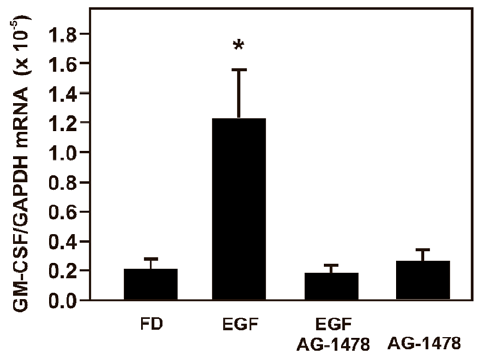
Figure 4. EGF up-regulates GM-CSF mRNA expression in B6Tert-1 cells. (A) Bar graph of real-time RT-qPCR data of GM-CSF mRNA expression in B6Tert-1 cells treated with EGF. FD: untreated; EGF: 50 ng/ml; AG-1478: 5 m M. Cells were pre-treated with AG-1478 for 30 min and then with 10% CSE for another 5 h. The asterisk (*) indicates a statistically significant difference ( p , 0.05) when compared with the untreated (FD) cells.